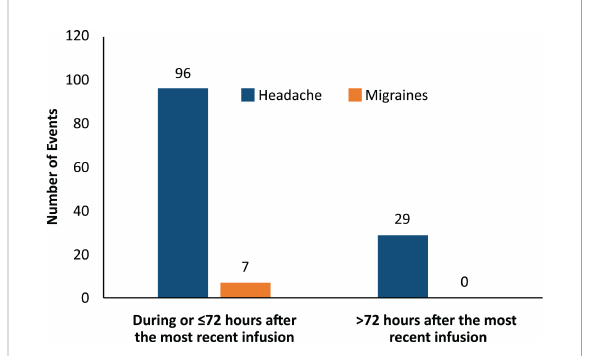
FIGURE 3 Timing of migraine and headache relative to the start of the